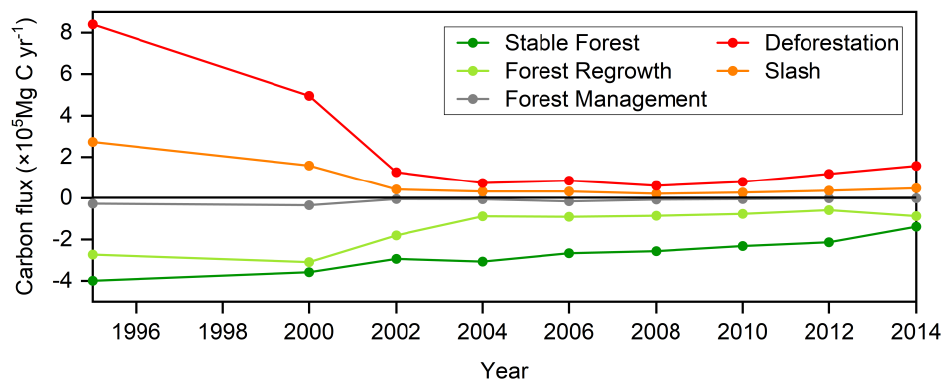
Figure 6. Carbon emission and uptake details of forest activities, suggesting pool capabilities for Guangzhou over 1995 – 2014.